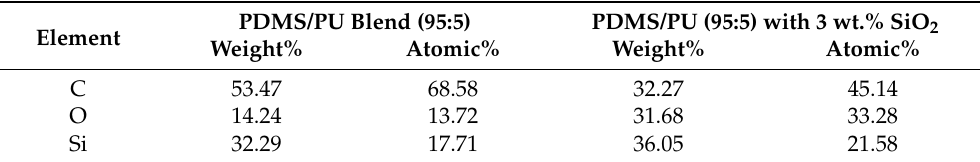
Figure 10. SEM-EDX image of: ( a ) PDMS/PU blend (95:5); ( b ) PDMS/PU (95:5) with 3 wt.% SiO 2 composites. Table 2. EDX analysis results including weight and atomic percentage of various elements found on the surface of the